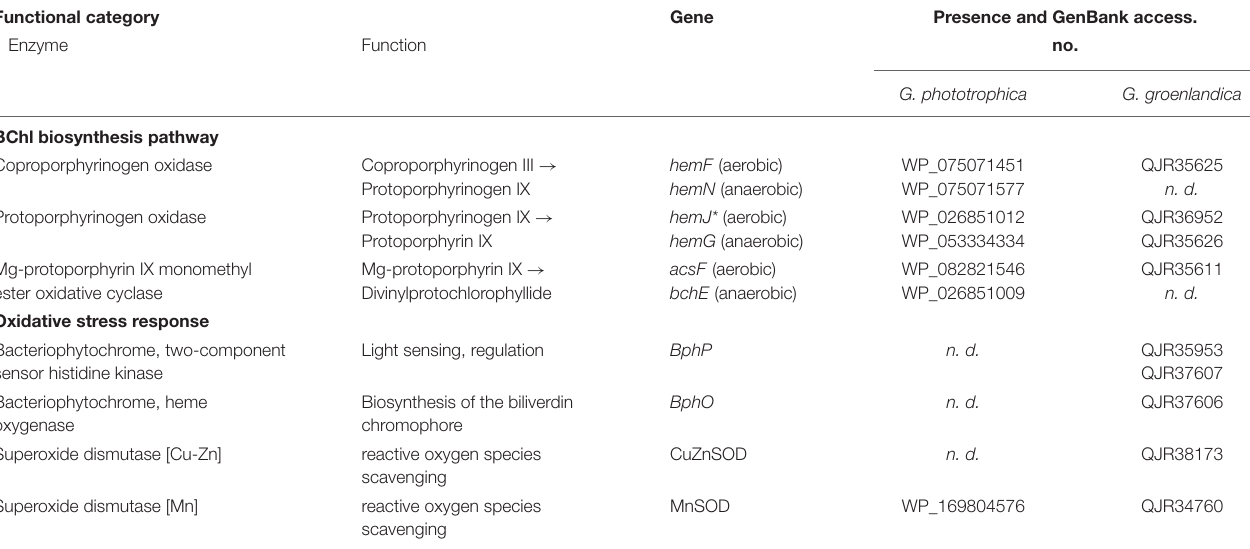
TABLE 2 | Key differences in the presence of genes related to bacteriochlorophyll (BChl) biosynthesis (only including three enzymes that have both aerobic and anaerobic versions) and genes related to oxidative stress response between Gemmatimonas phototrophica and Gemmatimonas groenlandica . Functional category Gene Presence and GenBank